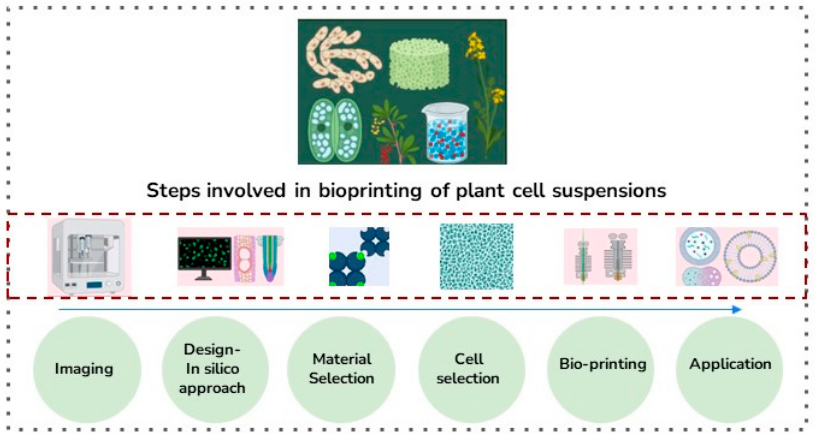
Figure 4. Di ff erent components of bioprinting using plant cell suspensions and its applications. Figure 4. Different components of bioprinting using plant cell suspensions and its